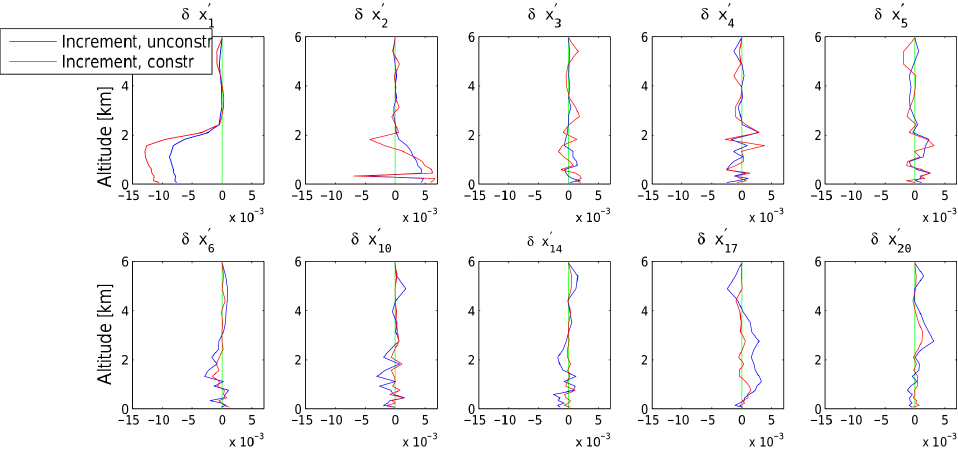
Figure 4. Vertical profiles of the transformed model variables δ x (cid:48) , defined in Eq. (9). The figure shows results obtained with the constrained (red) and unconstrained (blue) 3DVAR